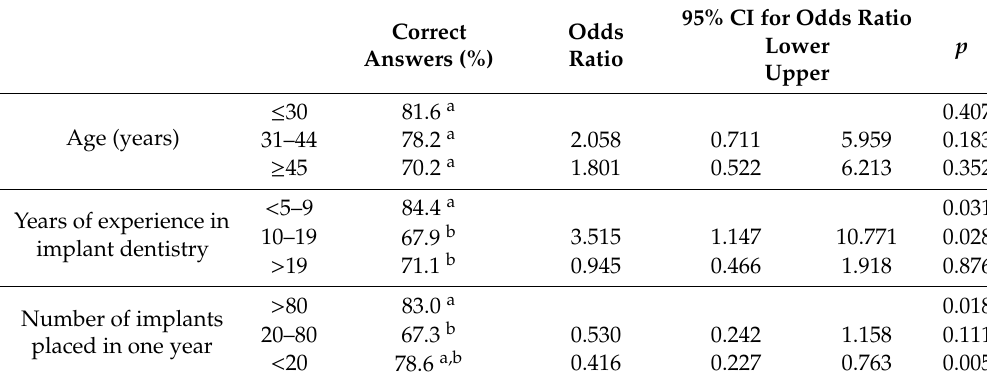
Multivariable analysis considering the correct answer on radiographic imaging for retrograde